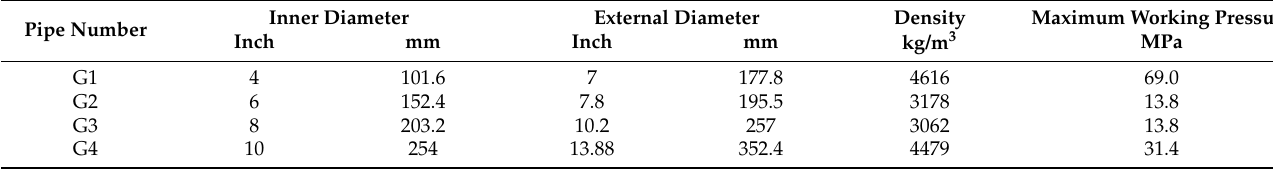
Table A1. Physical parameters of the flexible pipeline.